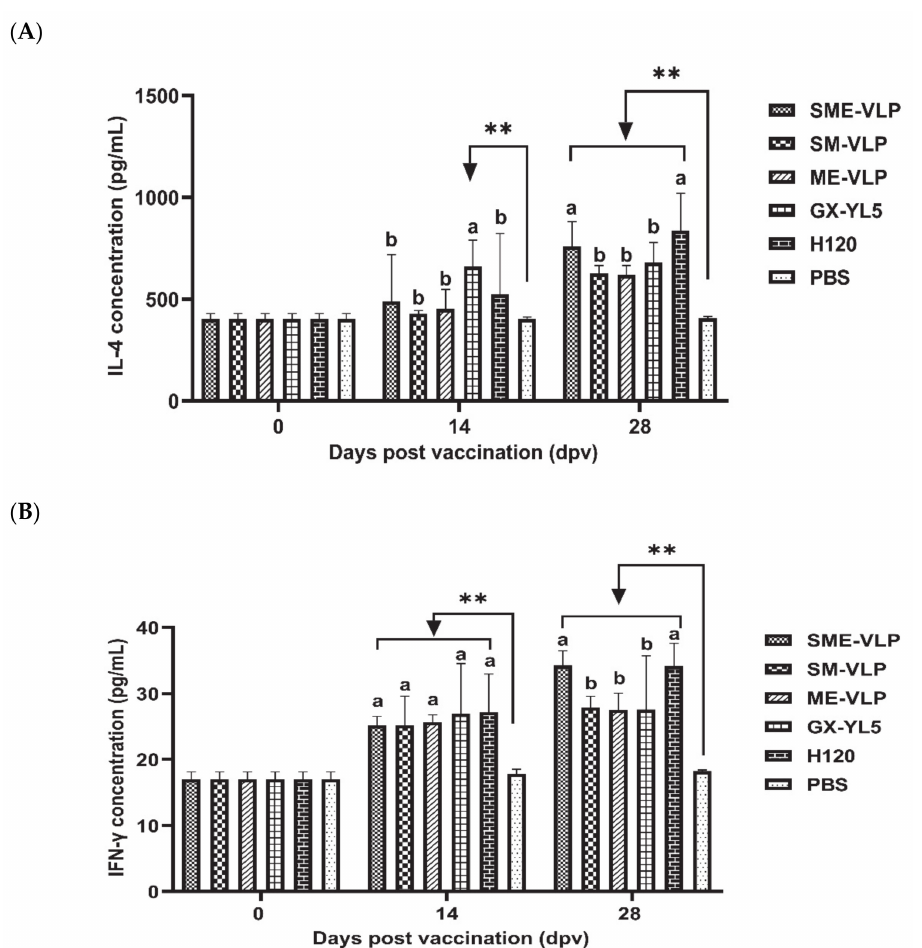
Figure 9. IL-4 and IFN- γ concentrations in the sera of vaccinated chickens at 0, 14 and 28 dpv. ( A ) IL-4 concentrations. ( B ) IFN- γ concentrations. Letters (a,b) indicate significant differences among vaccinated groups ( p < 0.05). ** indicates p < 0.01 between vaccinated and nonvaccinated groups. ( n = 10